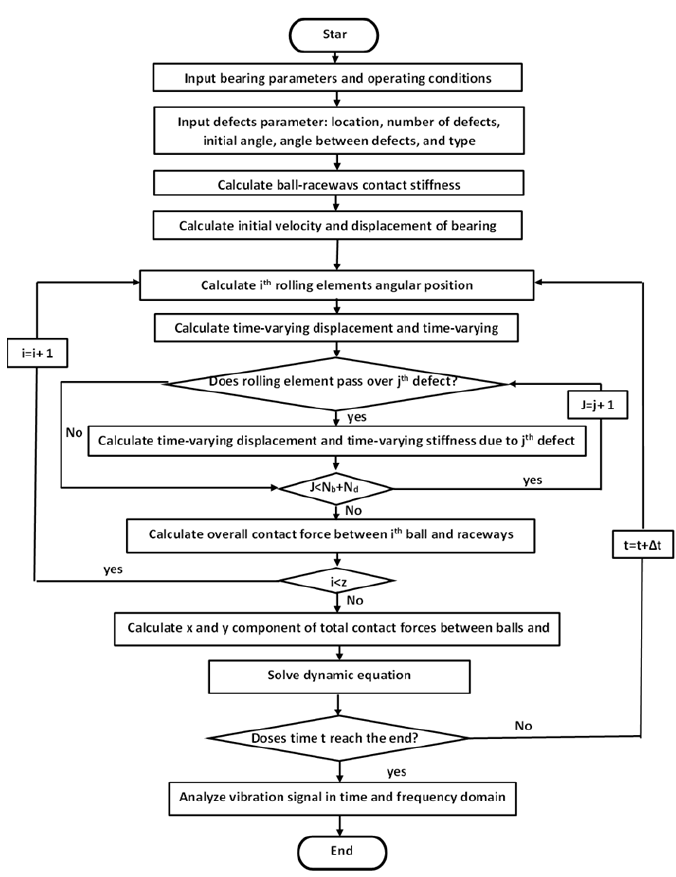
Figure 3. Flow chart of solution procedure of dynamic equations of bearing model.